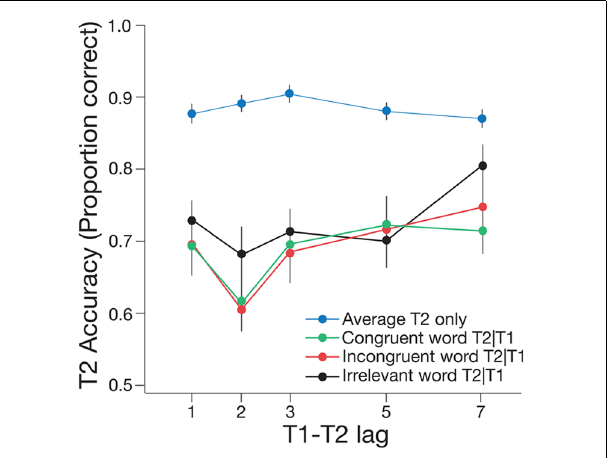
FIGURE 4 | Mean accuracy ofT2|T1 identification for the congruent, incongruent, and irrelevant word conditions of Experiment 2, plotted as a function ofT1–T2 lag. Mean accuracy for identifyingT2 only is also shown, pooled across the three word conditions. One lag corresponds with 66.6 ms. Error bars represent one standard error of the